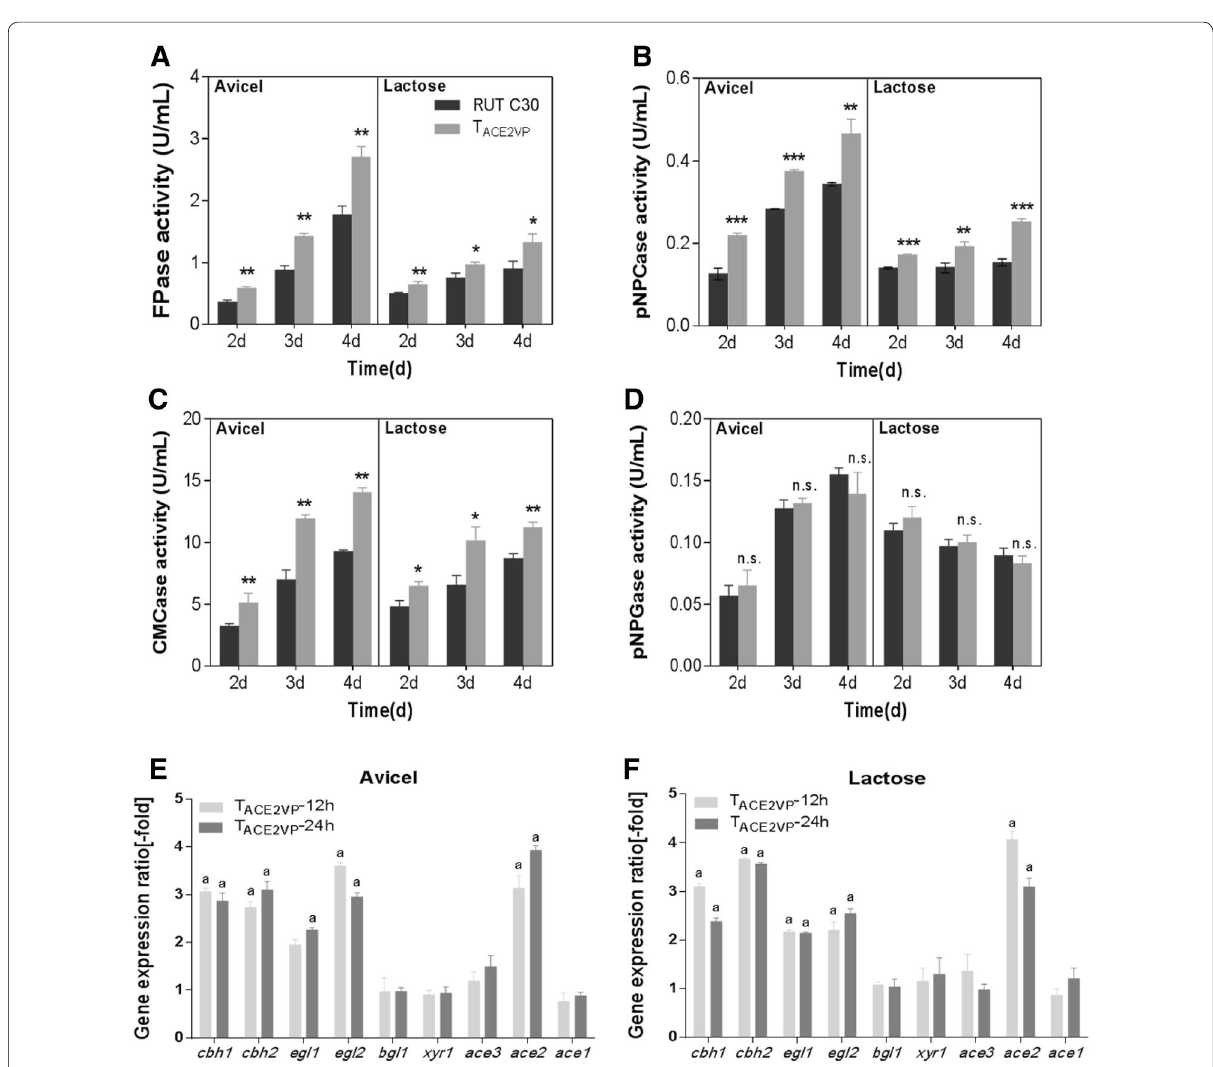
Fig. 4 Cellulase production and a comparison of transcript levels of cellulase-related genes between T ACE2VP and RUT C30. FPase ( A ), p NPCase ( B ), CMCase ( C ), and p NPGase ( D ) activities of RUT C30 and T ACE2VP after the switch from glycerol to 20 g/L Avicel or lactose. Enzymatic activities were measured at 2, 3, and 4 days after the transfer. Error bars show the respective standard deviations of three biological replicates; asterisks indicate significant differences (* P 0.05; ** P 0.01; *** P 0.001; n.s. not significant) between the transformants and RUT C30, as assessed by Student’s t ≤ ≤ ≤ test. Expression ratios of cellulase-related genes on 20 g/L Avicel ( E ) or lactose ( F ) for 12 and 24 h after the switch from glycerol. Data on T ACE2VP transformants were normalized to the corresponding gene expression at the same time points in RUT C30. Values represent the mean of three biological replicates, and error bars denote standard deviations. Gene expression ratios greater than twofold or less than 0.5-fold are marked with